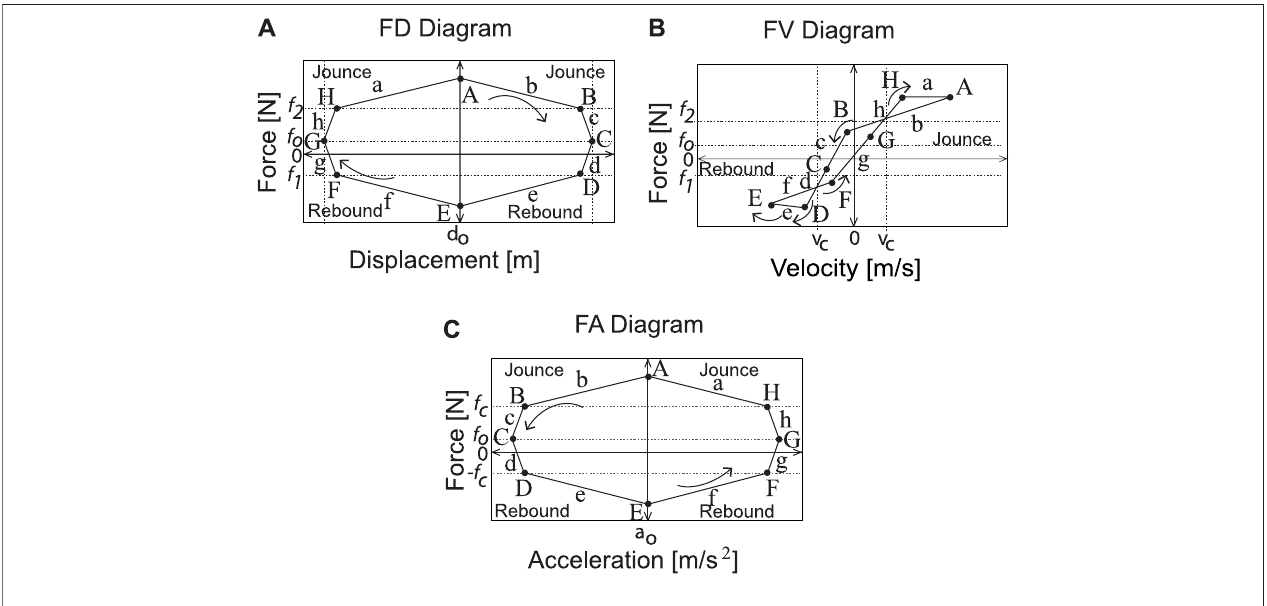
FIGURE 2 | Characteristic